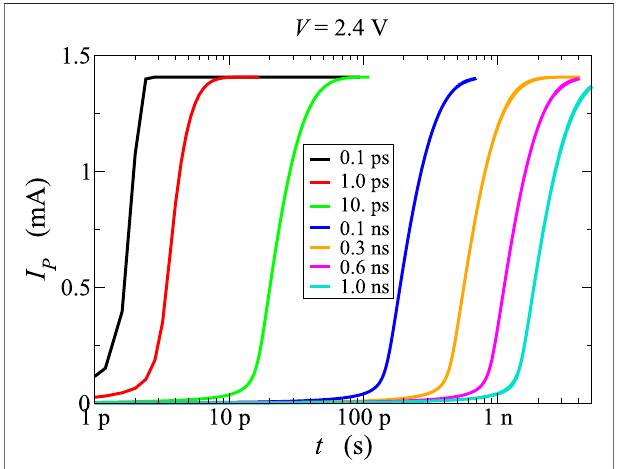
FIGURE 3 | Current fl owing across the PCM device as a function of time aftertheapplicationofa2.4 Vexternalvoltagestepat t =0.Differentvaluesfor the microscopic parameter τ n have been tested.